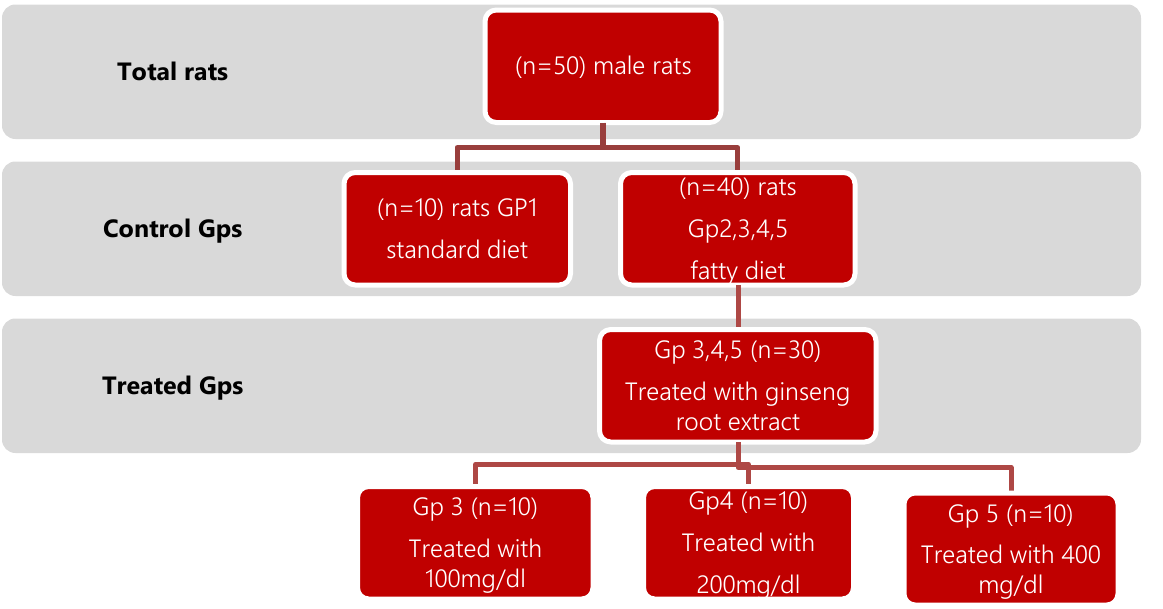
Figure 1: Schematic distribution for each